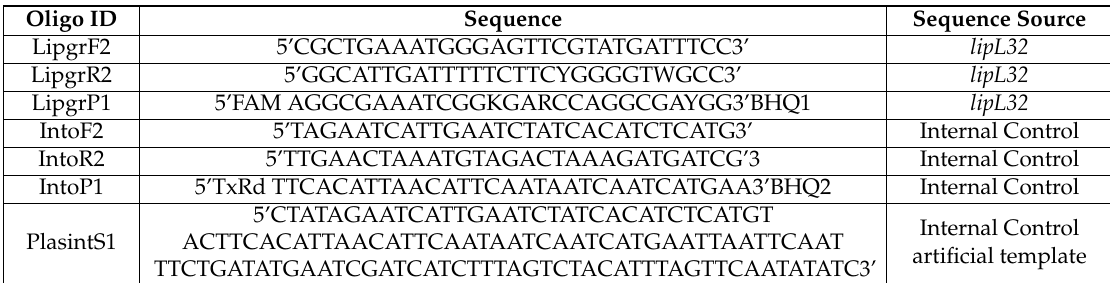
Table 2. Description of the sequence of lipL32, internal set primers, probe, and synthetic internal control used in the